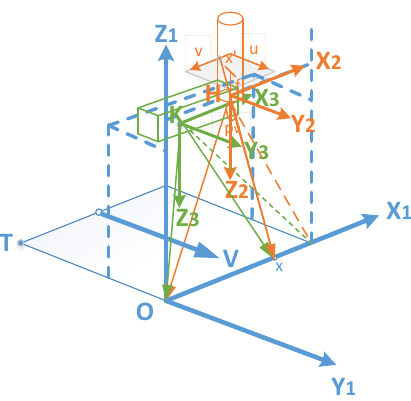
Figure 5. The fusion principle of pushbroom camera and depth sensor model. Starting from T, the line camera with focal length f and principal point pv is moved along V. The object point x is projected to the image point x’, with the coordinate (u; v).The coordinates of the base platform, hyperspectral camera, and Kinect V2 were O-X 1 Y 1 Z 1 , H-X 2 Y 2 Z 2 , and K-X 3 Y 3 Z 3 , respectively, which were aligned with each other.